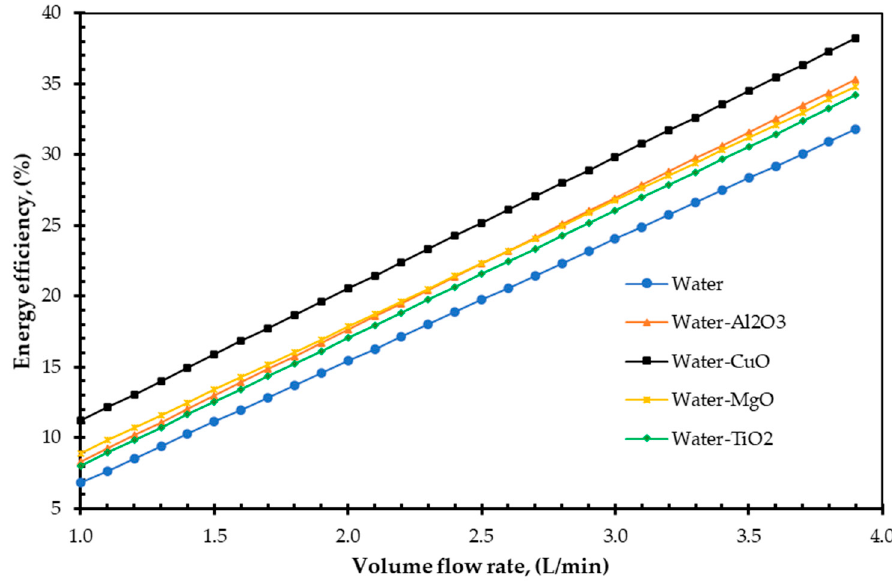
Figure 2. Effect of volume flow rate on energy efficiency.